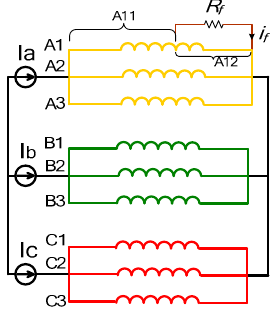
Figure 7. The stator circuit schematic with ITSF in the A phase.